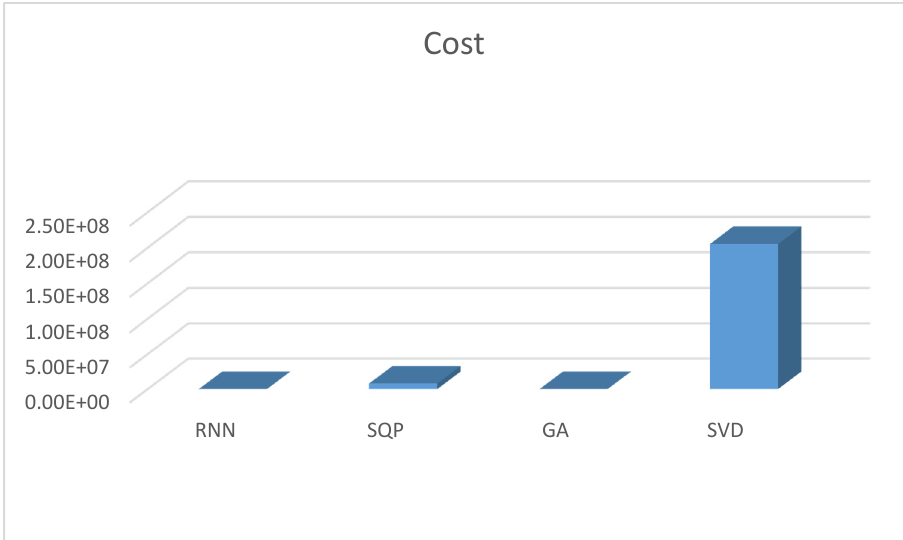
Figure 9. The cost function of different optimization algorithms.